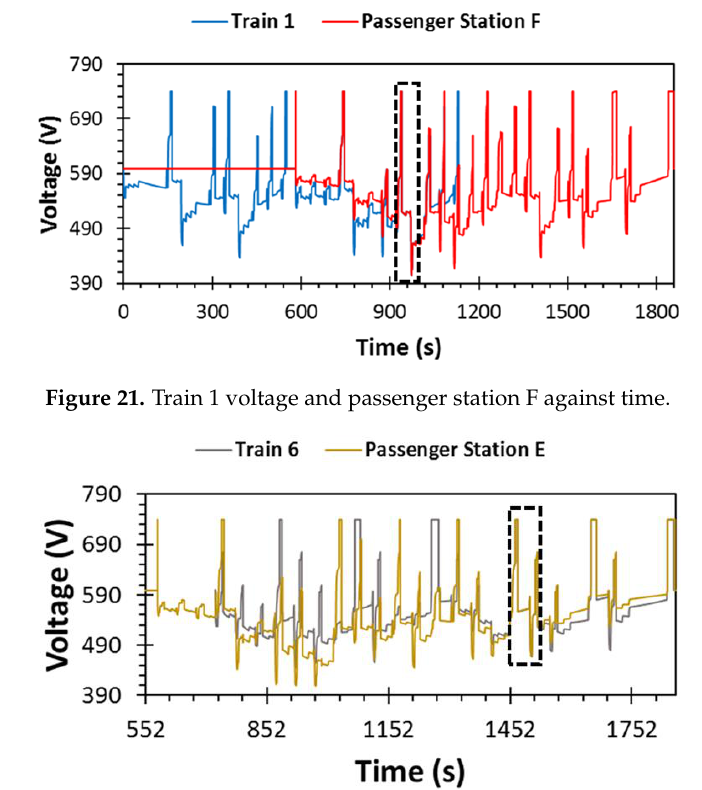
Figure 22. Train 6 voltage and passenger station E against time.